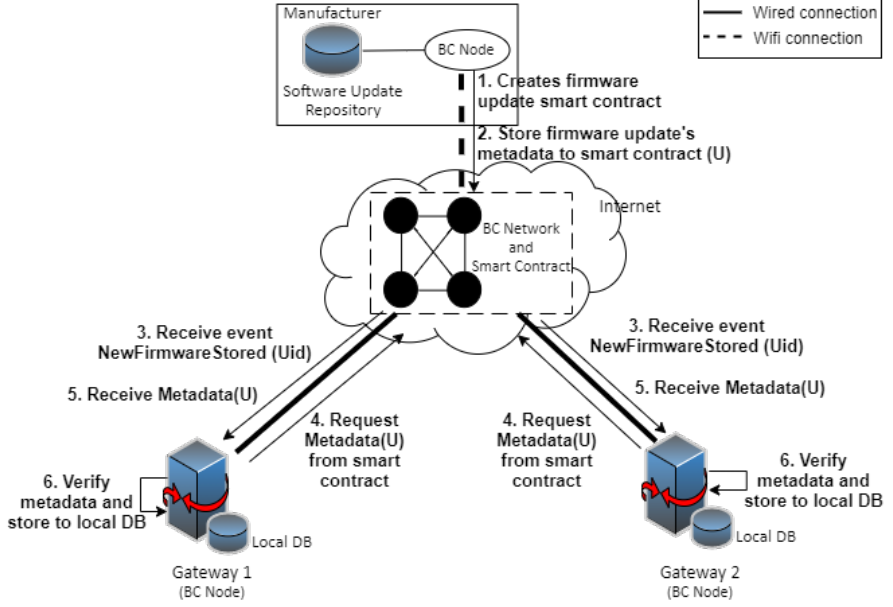
Figure 6. Implementation of creation of firmware update smart